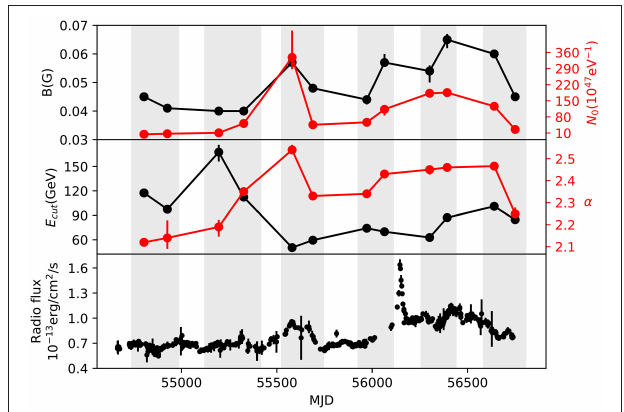
FIGURE 3 | The evolution of the parameters of the SED, with the periods chosen in gray, with the radio lightcurve (shifted by the lags found in section 3) on the bottom for comparison.